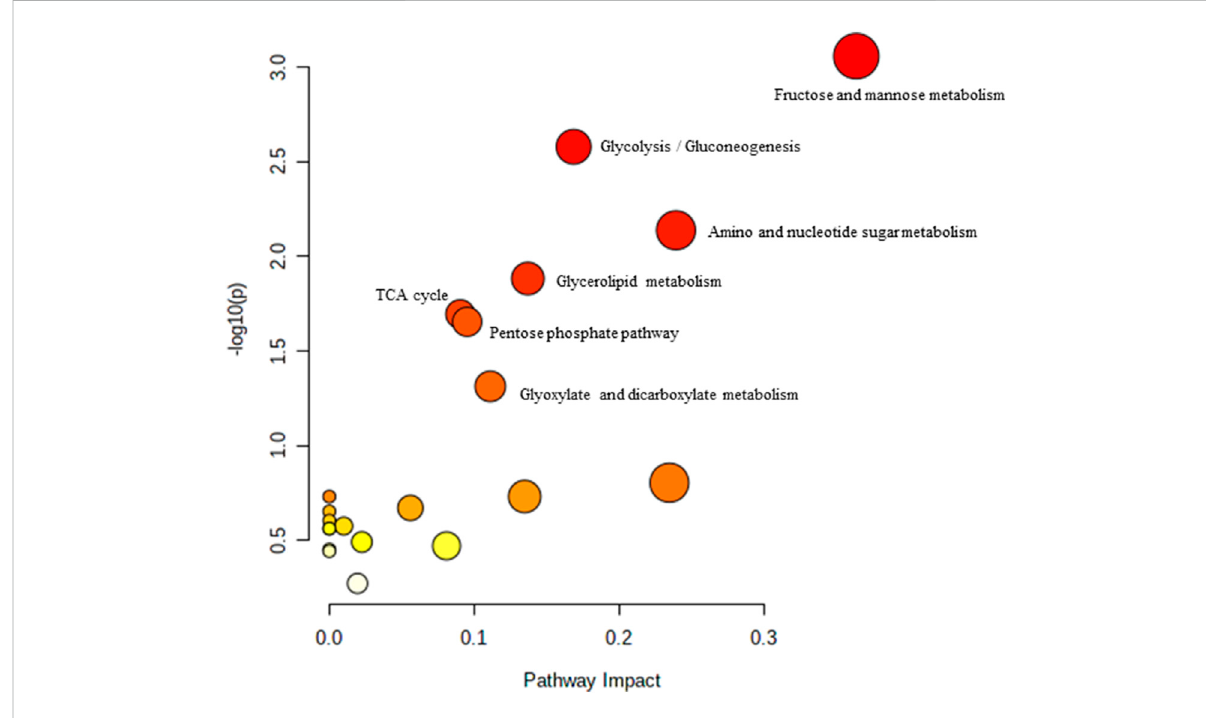
FIGURE 2 Biochemical pathway analysis of metabolites pro fi led for YC vs. AC.